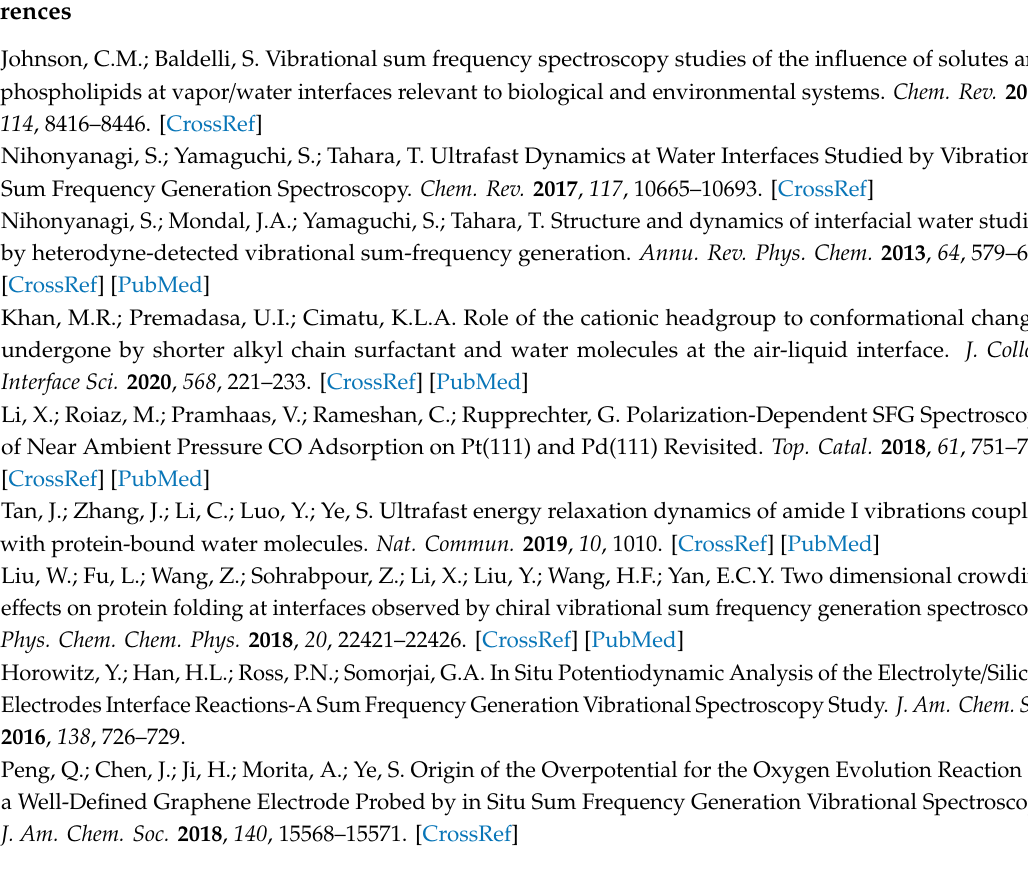
Figure S1: Schematic of broadband SFG (BB-SFG) experimental setup. Figure S2: Determination of the FWHM value of the SPP modes. Table S1: Dip positions and FWHM values of the SPP modes of the Au NHAs. Author Contributions: W.G. performed the SFG experiment, analyzed the data, and drafted the manuscript. B.L. fabricated the Au NHAs and performed the optical measurements. Y.H. helped with the experiment design and participated in manuscript preparation. E.Y., Y.Z., and J.W. checked the data and improved visualization.